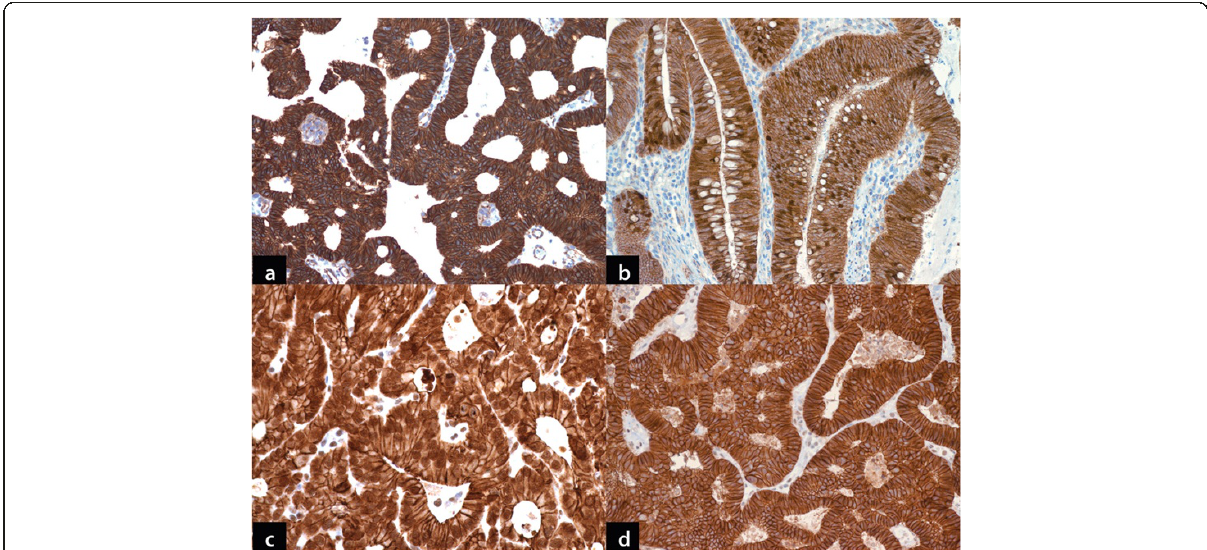
Figure 2 a: Primary bladder adenocarcinoma . Strong cytoplasmic membranous staining with β -catenin (DAB chromogen, x100). b : Metastatic colorectal adenocarcinoma. Strong nuclear staining in addition to cytoplasmic staining with β -catenin (DAB chromogen, x100). c : Primary bladder adenocarcinoma. Strong nuclear staining with e-cadherin in addition to weaker cytoplasmic staining pattern. This pattern was more frequent in this group of tumor in contrast to metastatic colorectal adenocarcinoma (DAB chromogen x200). d : Metastatic colorectal adenocarcinoma. Prominent cytoplasmic membranous staining with e-cadherin. Note the absence of nuclear staining (DAB chromogen, x200).